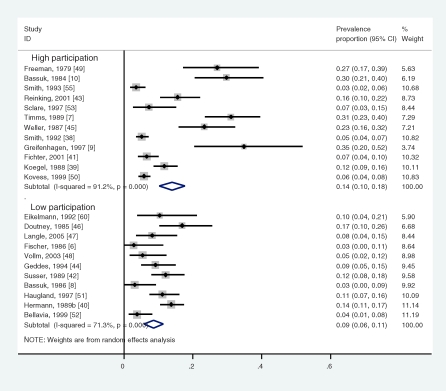
Prevalence of Psychosis in Homeless Persons by Participation Rate